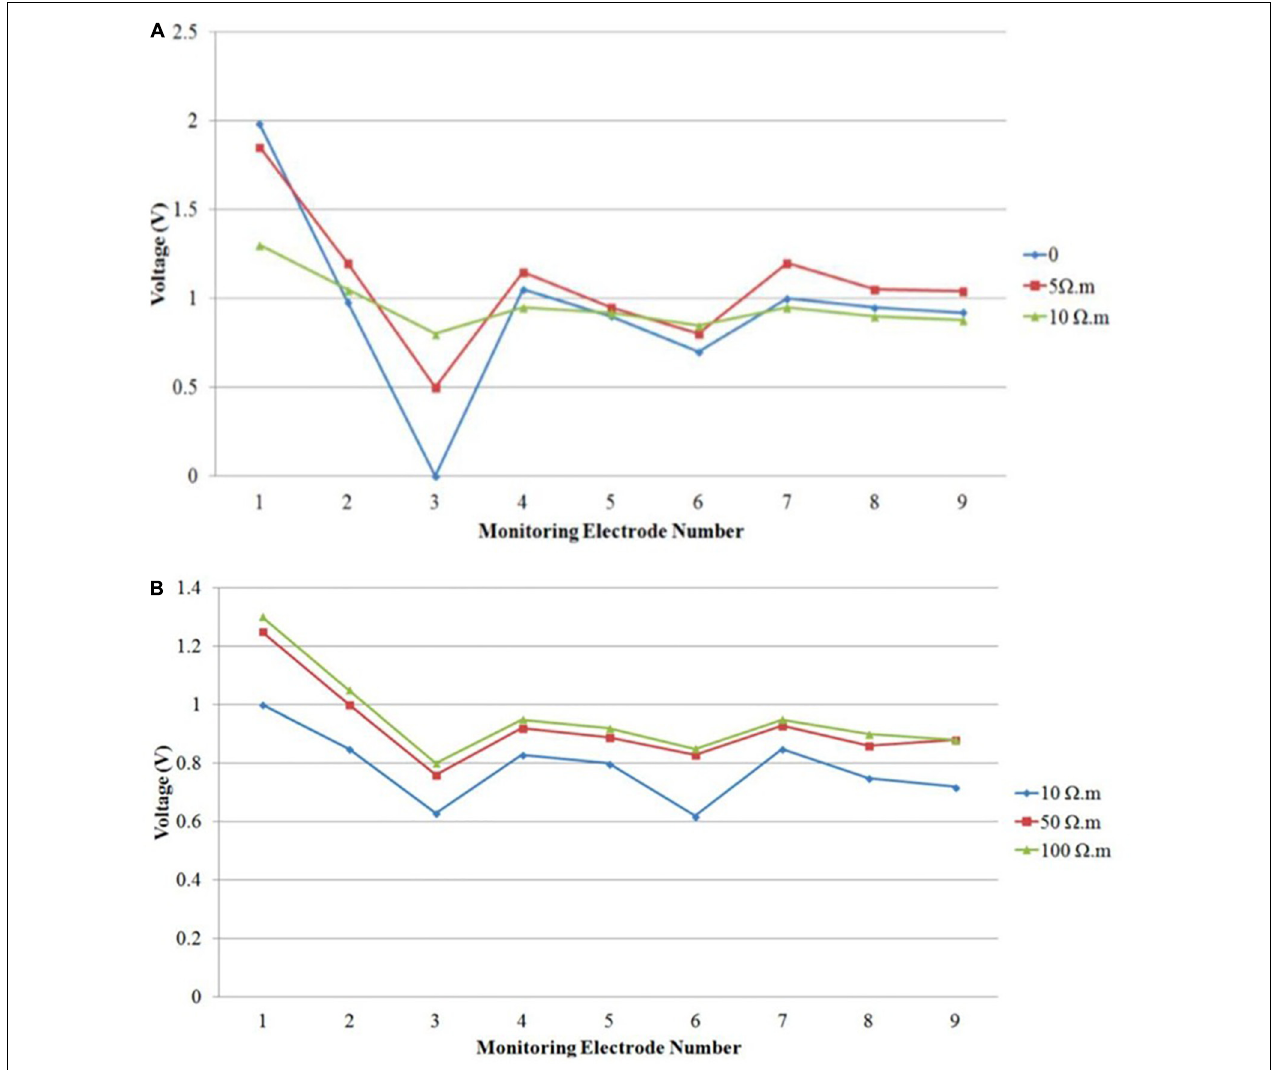
FIGURE 15 | Simulated voltage distribution on the skull layer at nine monitoring electrodes using tDCS montage: anode over left DLPFC, cathode over right DLPFC, and using different contact gel resistivity (A) 0, 5, and 10 (cid:127) m; (B) 10, 50, and 100 (cid:127)